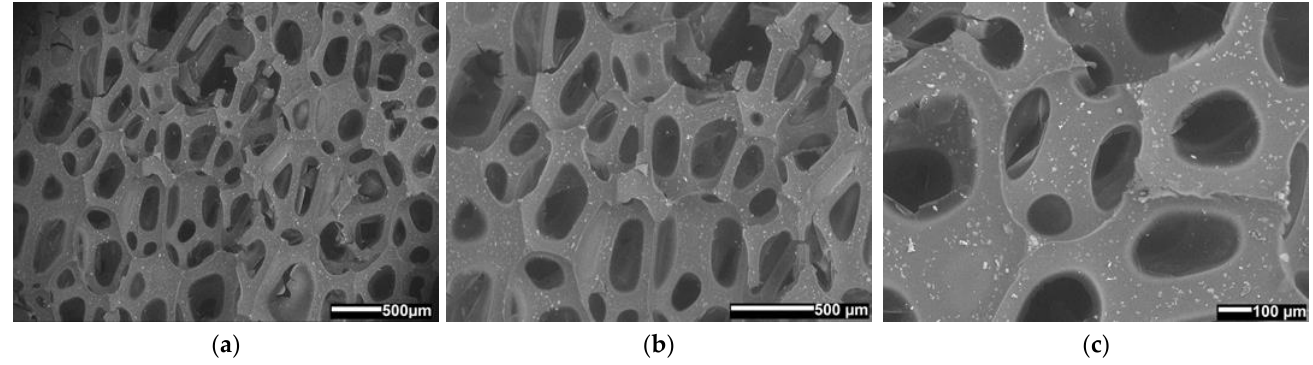
Figure 16. SEM micrographs of the surface of expanded solid polymer PUR 1 sample; at magnification ( a ) 30×, ( b ) 50×, and ( c ) 100×.